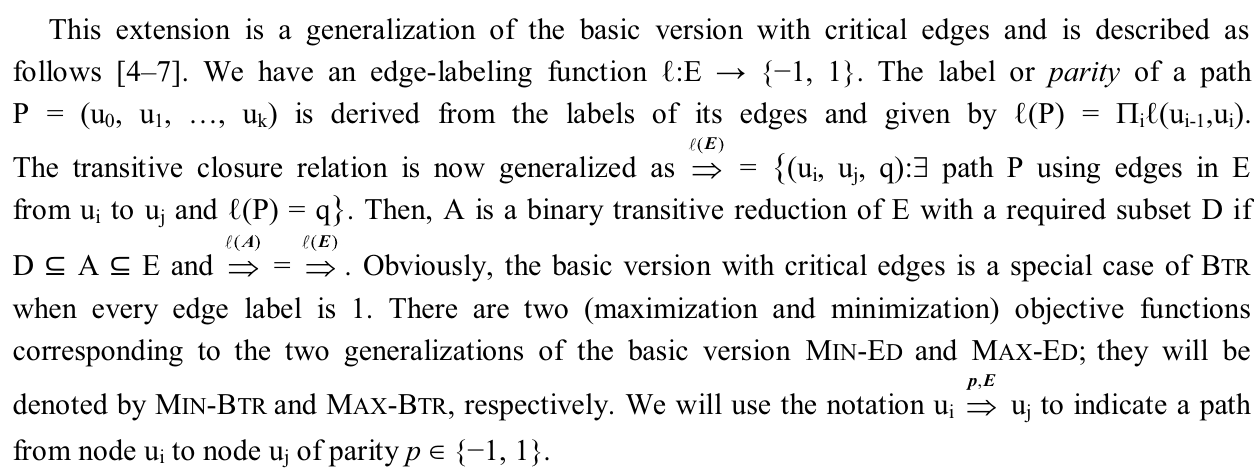
) and (V, A ) of M IN -E D for G. 1 2